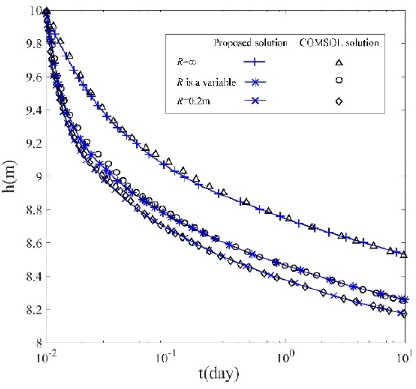
Figure 2. Comparison of the hydraulic head − time curves of analytical and numerical solutions.